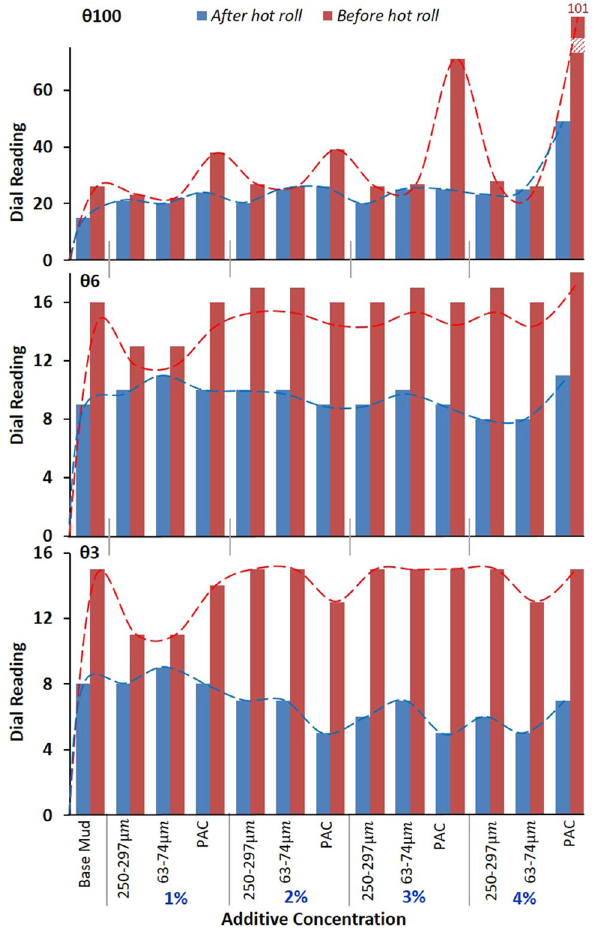
Fig. 13 A comparative analysis illustrating the variation in shear stress in terms of the dial reading in a decreasing pattern from θ100 to θ3 before and after hot roll. It is seen that the dial readings of θ100 are showing similar results shown in Fig. 12, but the shear rate at dial readings of θ6 and θ3 is showing deviations between the before and after hot roll readings at 2–4% concentrations